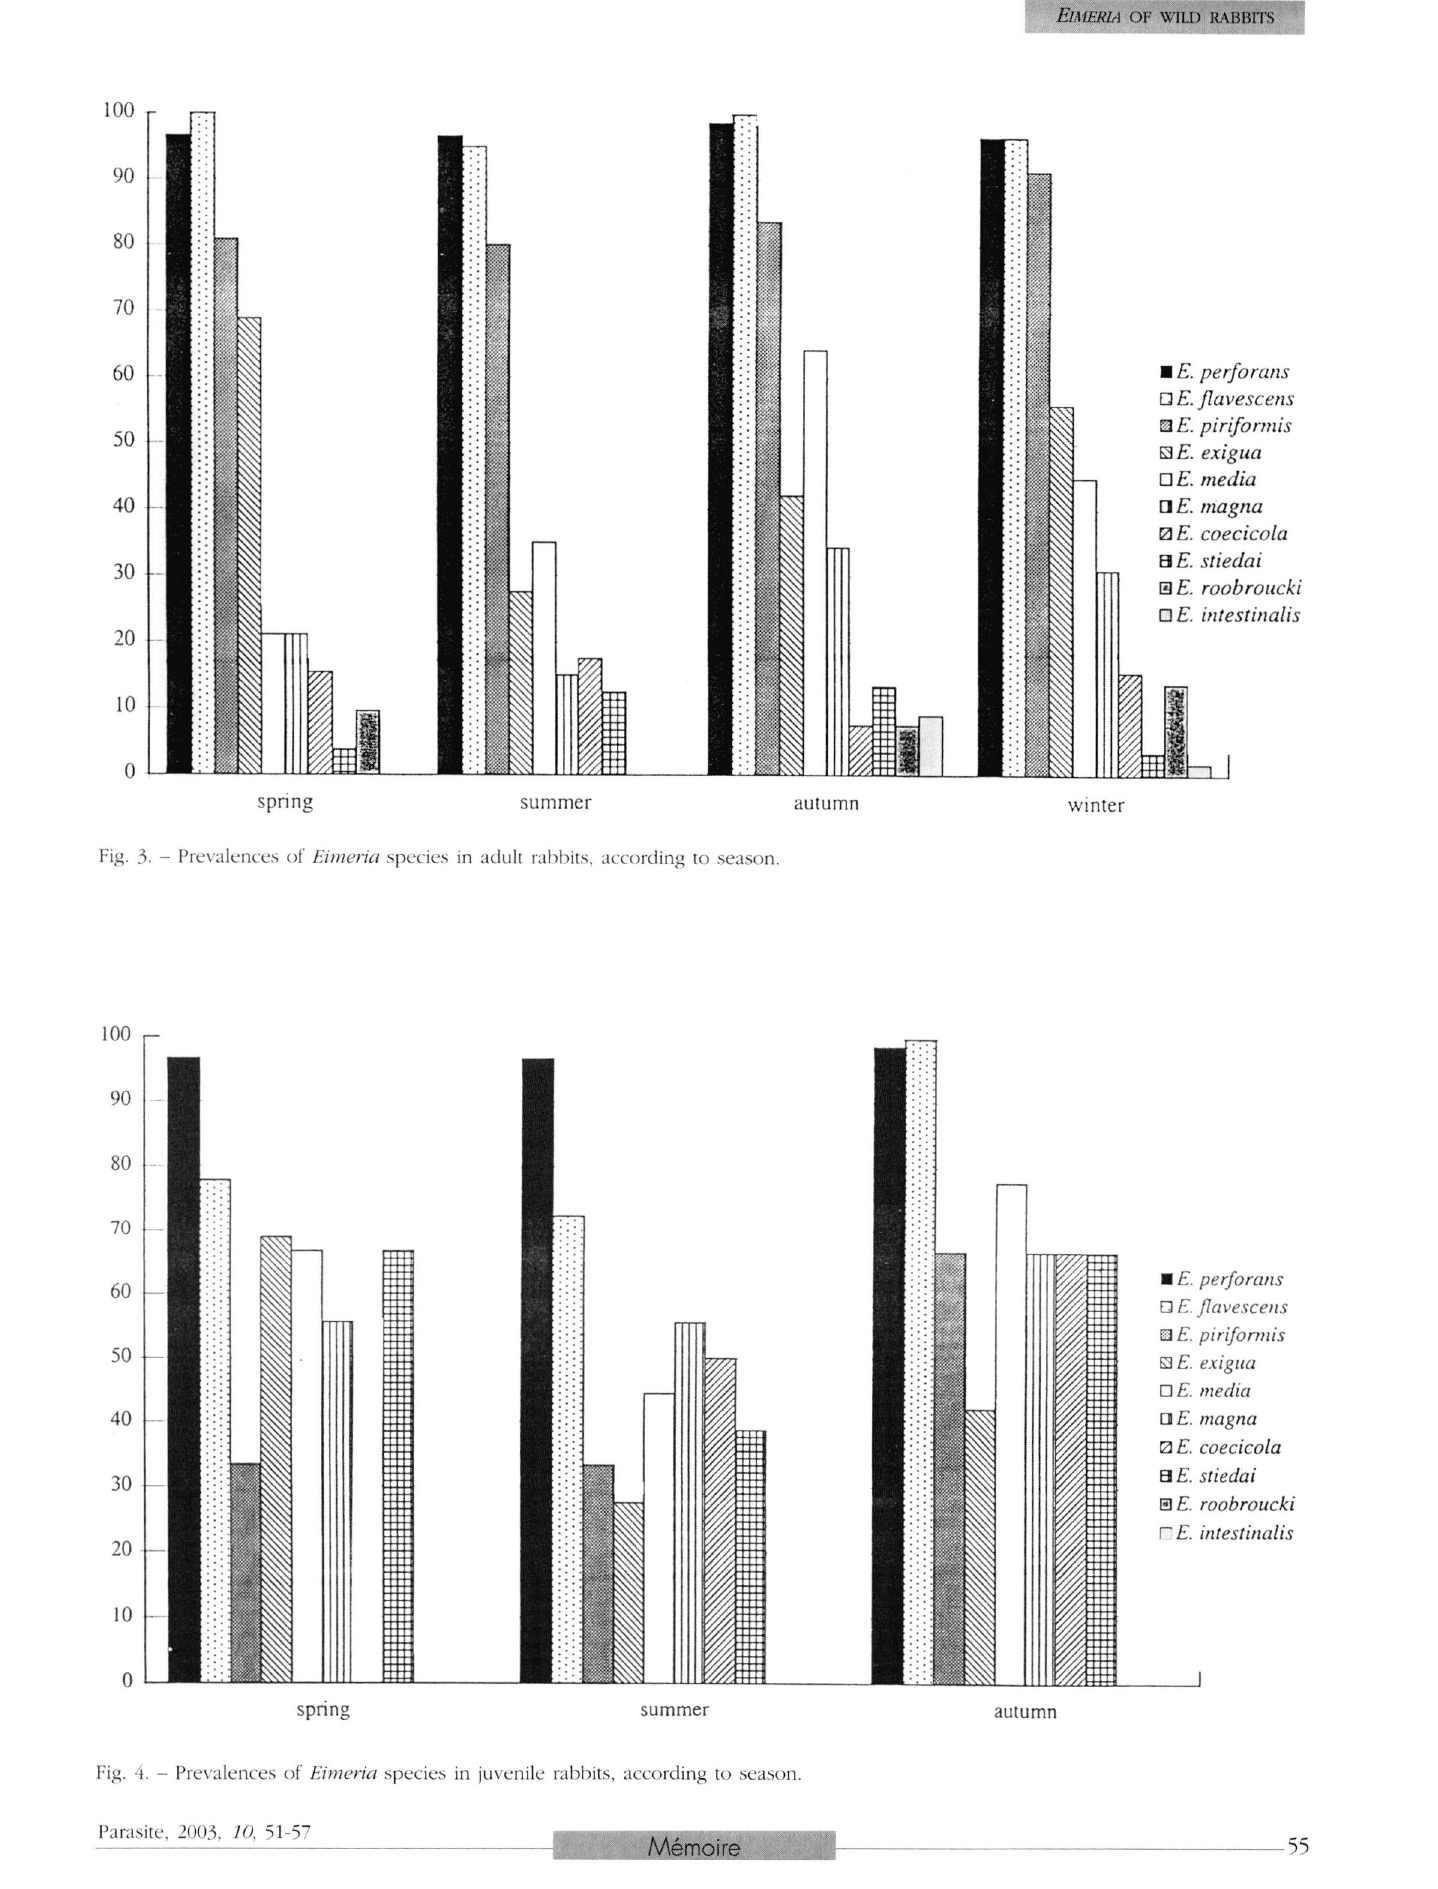
Parasite. 200.3. 10.